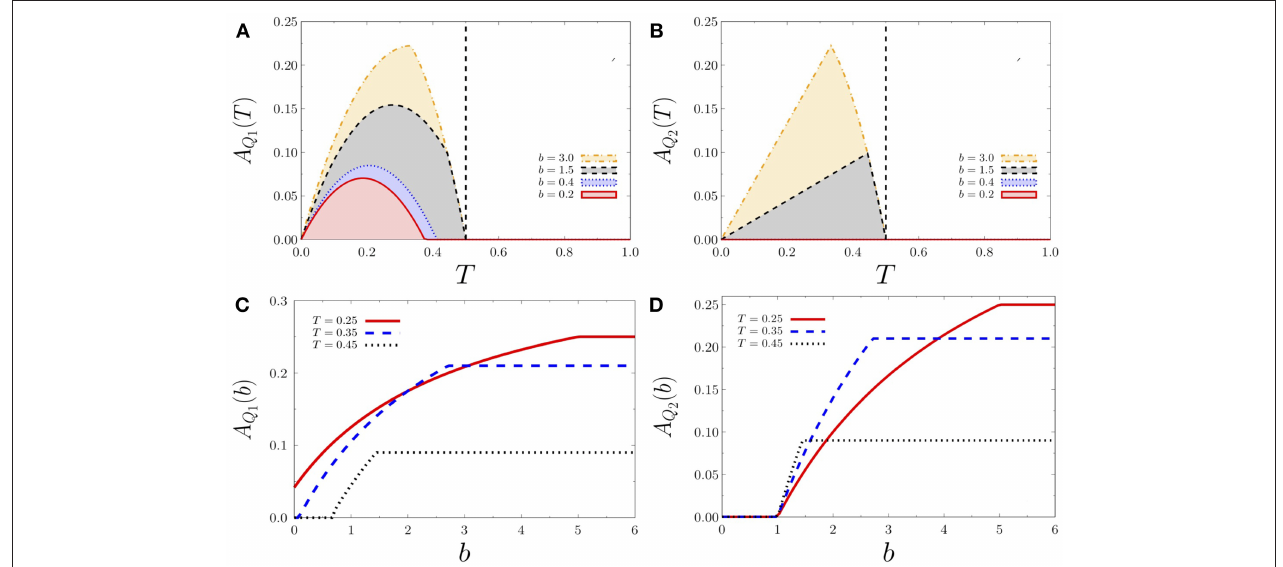
, as function of T for different values of b (A,B) and and A Q 2 1